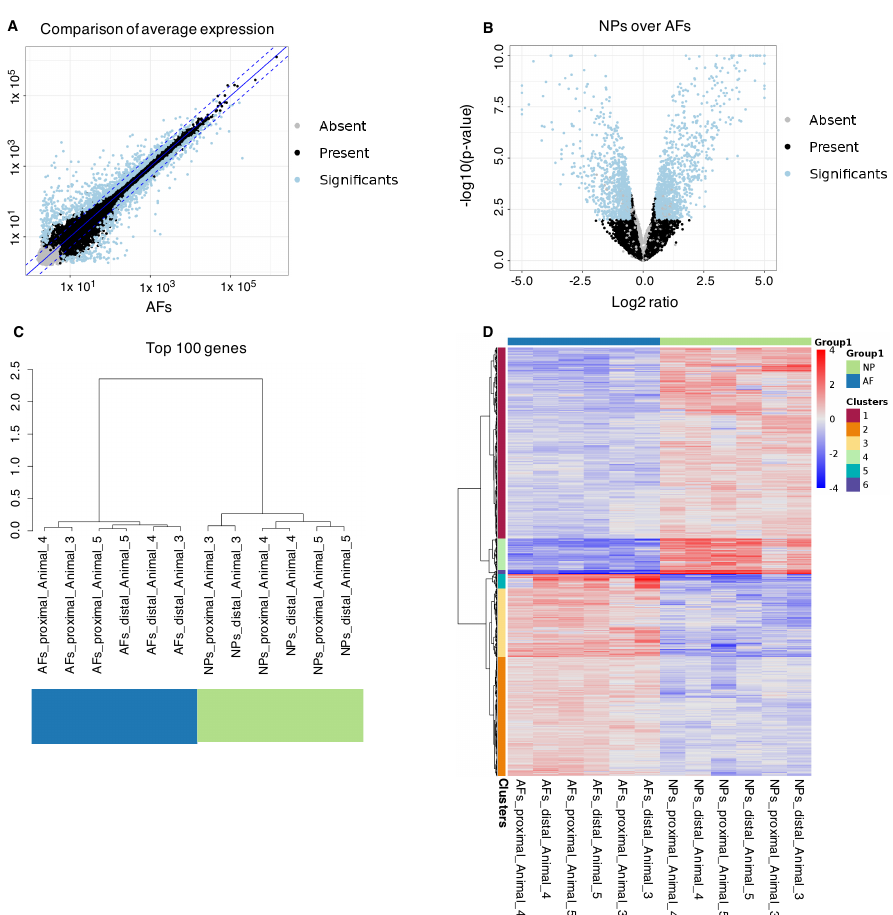
Figure 6. Comparison between NPs and AFs in the bulk RNAseq data. In the correlation graphic ( A ) is present a light correlation in the gene expression between all the (6) NPs and (6) AFs, with relevant differences. The volcano plot ( B ) shows a high number of significant differentially expressed genes with relevant fold changes between NPs and AFs. The dendrogram ( C ) compares the top 100 most expressed genes in the NPs and AFs. This shows a clear distinction between the gene expression of the NPs and the AFs, that clustered separately. Intra group, the NPs samples cluster per animal. In the AFs, instead, Animal 5 clustered together, while, for the Animals 3 and 4, the clustering occurs between the two proximal and the two distal samples. The heat map ( D ) shows a very clear distinction in the gene expression pattern of the NPs over the AFs. Here, the gene Clusters 1, 4 and 6 are upregulated in the NPs, while the gene Clusters 2, 3 and 5 are